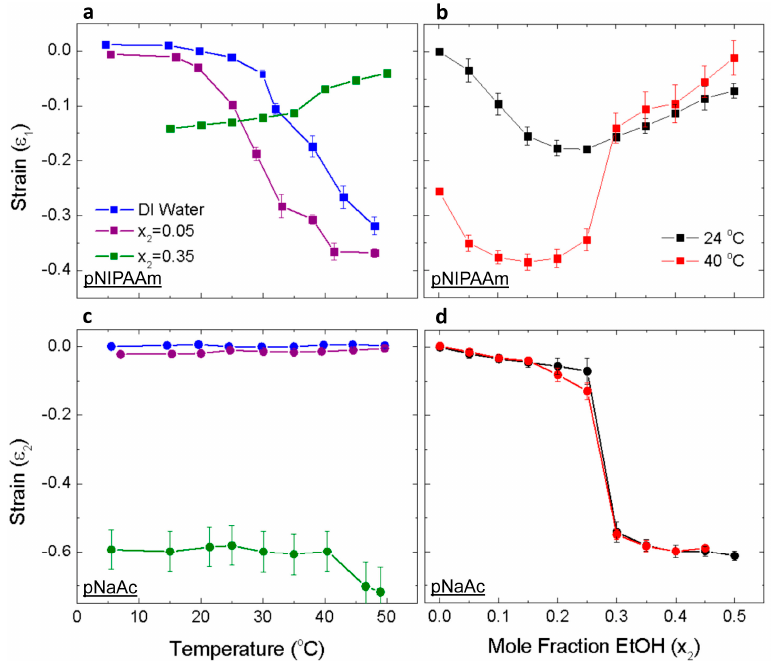
Figure 2. Response of the individual hydrogel layers to temperature and solvent quality. All reported values are relative to the reference state of room temperature water. ( a ) The actuation strain of pNIPAAm gel strips, ε 1 , in various mixtures of EtOH and water as a function of temperature. ( b ) The actuation strain, ε 1 , above and below the LCST as a function of solvent quality. ( c ) The actuation strain of pNaAc gel strips, ε 2 , in various mixtures of EtOH and water as a function of temperature. ( d ) The actuation strain, ε 2 , at 24 °C and 40 °C as a function of solvent quality. The errors bars represent the standard deviation (SD) of five samples.